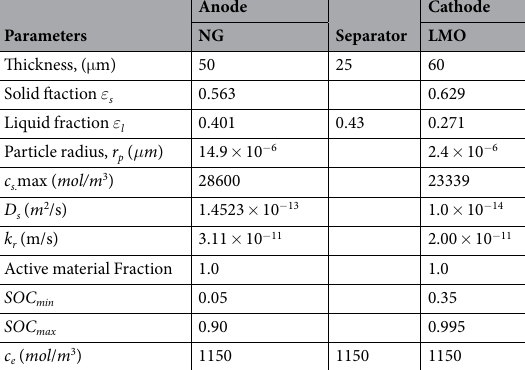
Table 1. List of parameters used in the